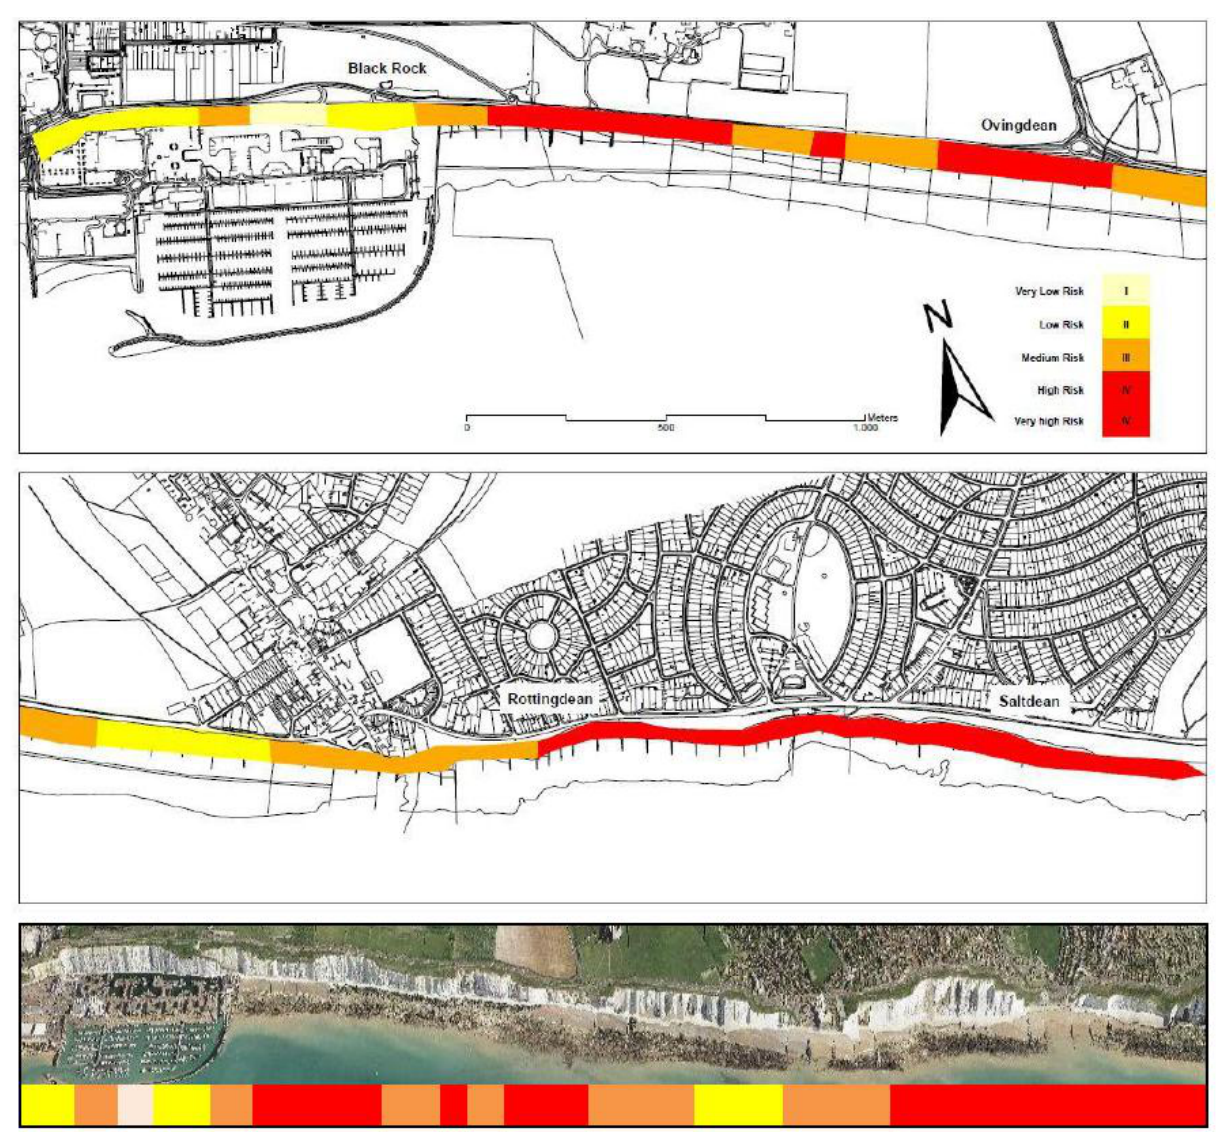
Fig. 10. The risk zonation plan of the